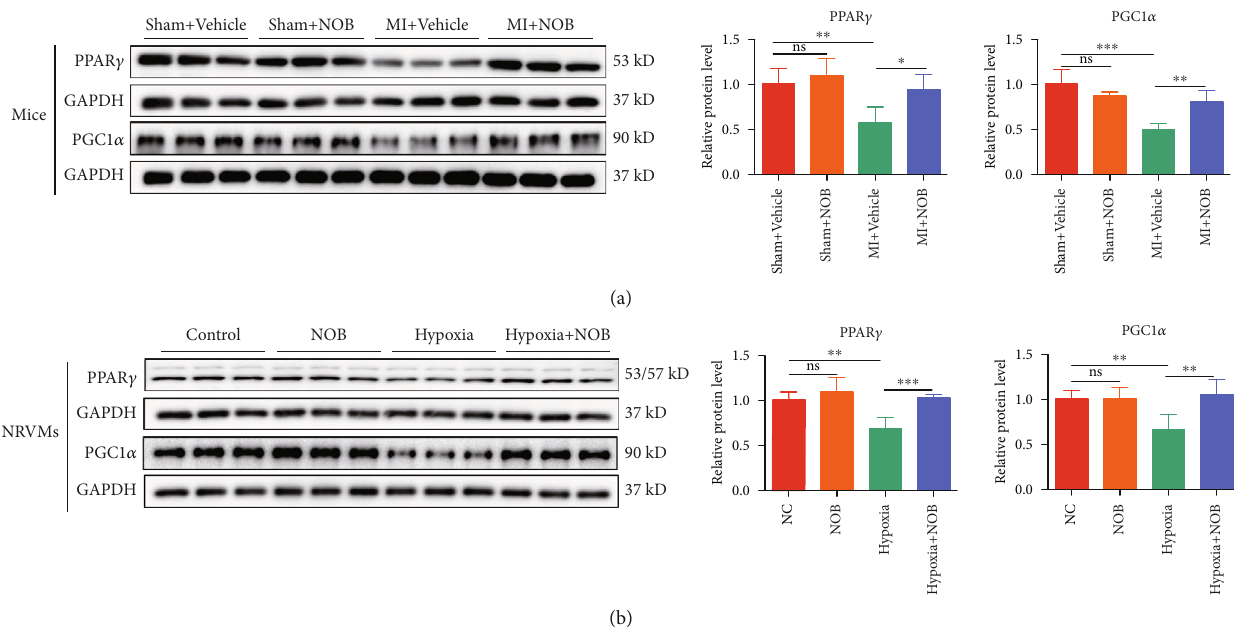
Figure 4: NOB activates PPAR γ and PGC1 α in vivo and in vitro . (a) In mouse hearts, PPAR γ and PGC1 α expression signi fi cantly decreased in the MI group, which was reversed by NOB intervention ( n = 6 per group). (b) The expression levels of PPAR γ and PGC1 α were higher in the NOB intervention group than in the hypoxia group ( n = 6 per group). Data are presented as mean ± SD . ∗ P < 0 : 05 ; ∗∗ P < 0 : 01 ; ∗∗∗ P < 0 : 001 ; ns P > 0 : 05 . NOB: nobiletin; PPAR γ : peroxisome proliferator-activated receptor gamma; PGC1 α : PPAR γ coactivator 1 α ; MI: myocardial infarction; NRVMs: neonatal rat ventricular